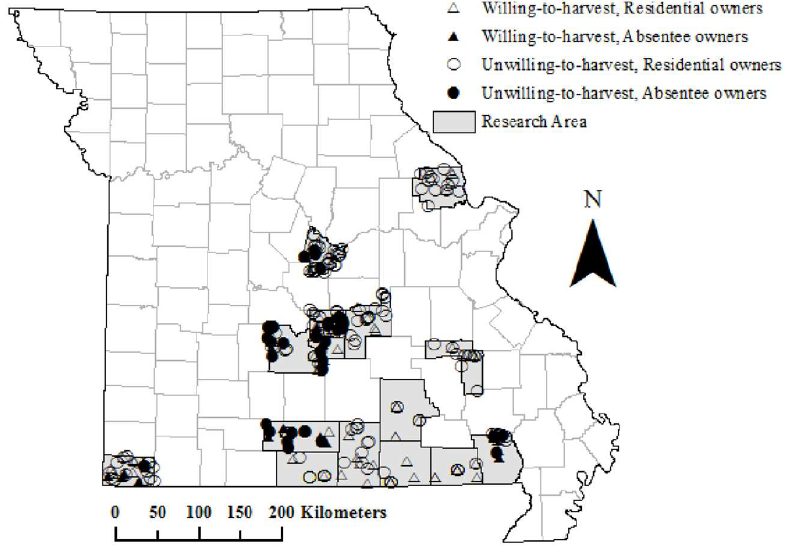
Fig 1. Georeferenced responses distinguishing between residential and absentee